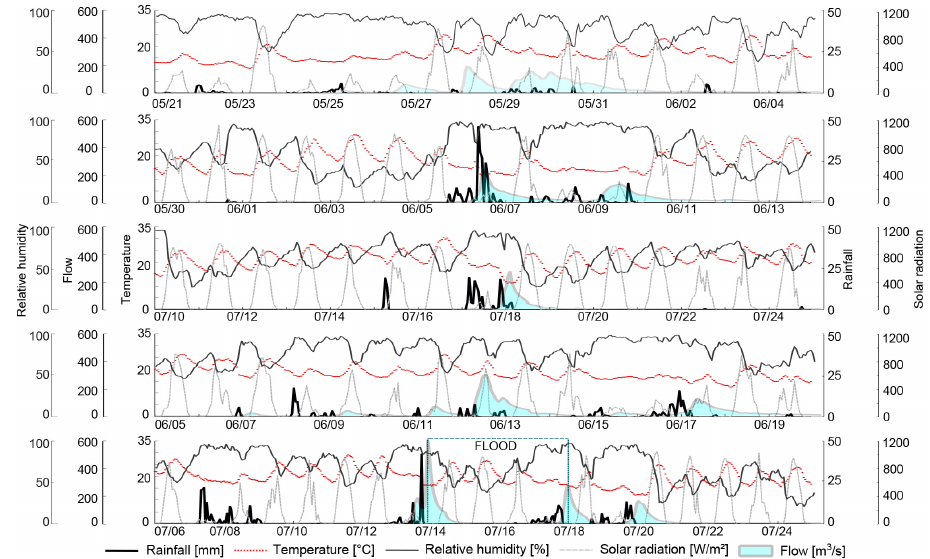
Figure 3. Meteorological and hydrological conditions 7 days before and after each flood. Floods are arranged according to Table 2, from top (2008) to bottom (2011). The first four floods were considered as single-peak events, and the flood in 2011 as a 5-day event with two peaks (delineated by